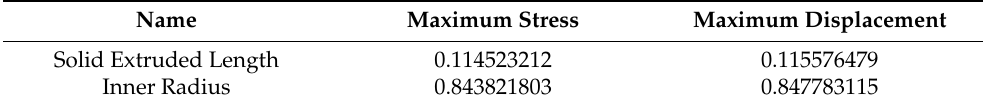
Table 1. Correlation table of first model.